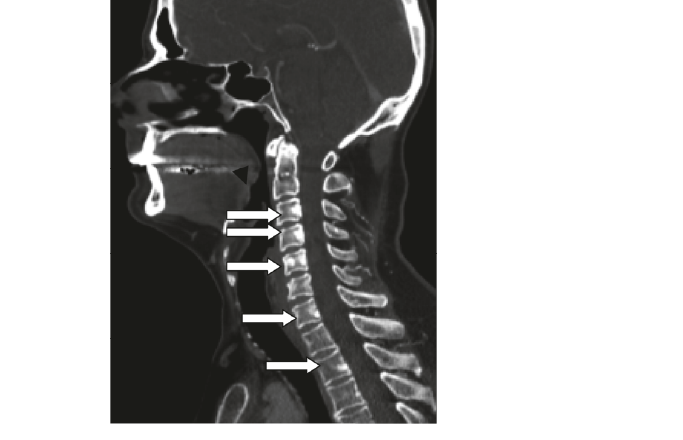
Figure 1: (Neck contrast enhanced CT) : Sagittal bone window CT demonstrating several osteoblastic lesions at C3, C4, C5, C7, and T2 (white arrows).